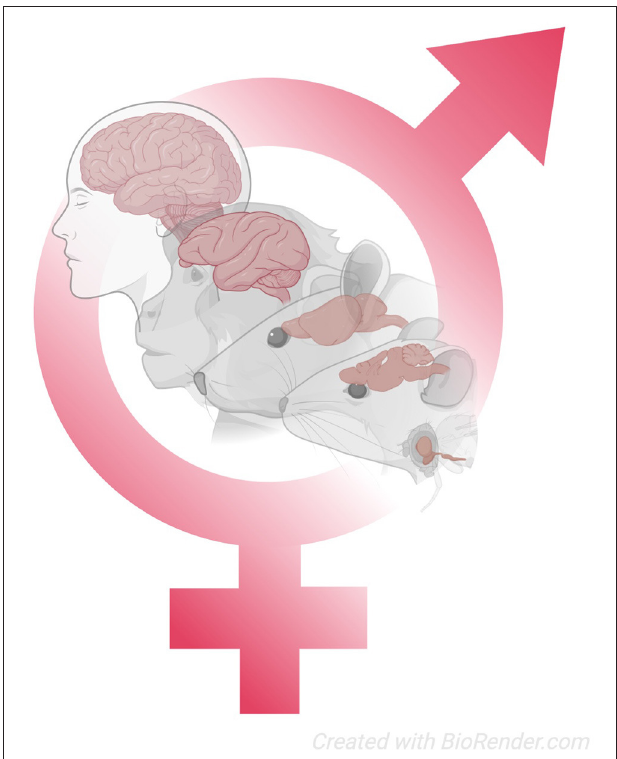
FIGURE 1 | Animal models of anxiety and depression: Exploring the underlying mechanisms of sex differences. Image created with